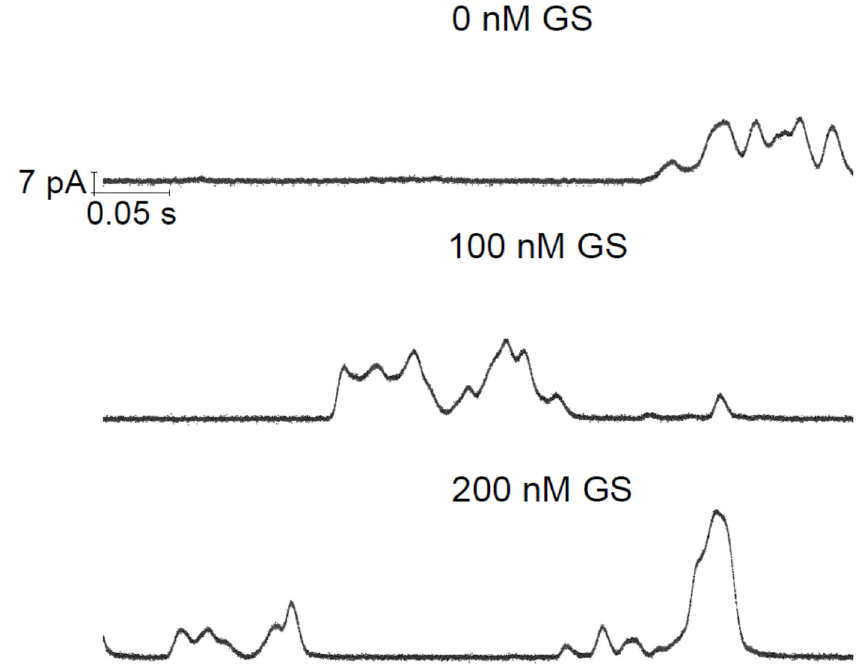
Figure 3. Short time (0.5 s) current traces: sections of Figure 2.